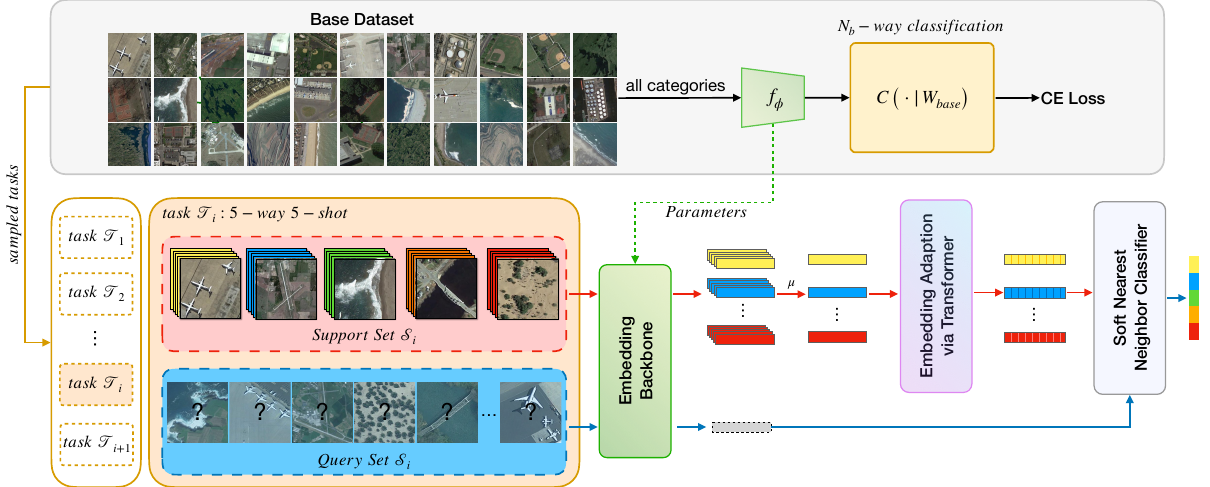
Figure 3. Overall framework of the proposed